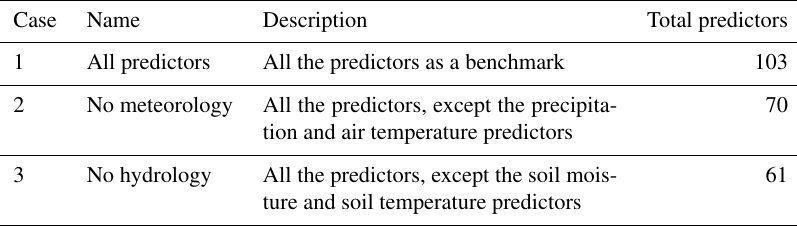
Table 2. Predictor sets applied to the maize yield modeling sensitivity experiments.